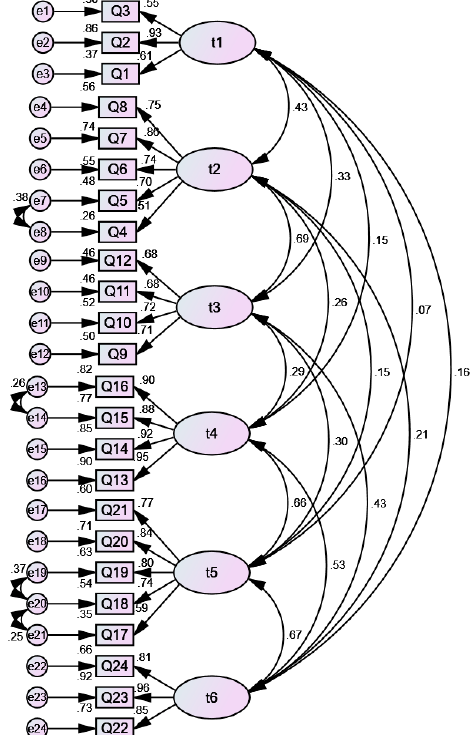
Figure 1. CFA of the QWLSKT. Model fit: χ 2 = 691.447, df = 235, p < 0.000, CFI = 0.91, TLI = 0.90, IFI = 0.91, RMSEA = 0.067 (90% CI [0.61, 0.73]), AIC = 821.447, BIC = 1086.494. CFA, confirmatory factor analysis; QWLSKT, quality of work life scale for kindergarten teachers; CFI, confirmatory factor index; TLI, Tucker-Lewis index; IFI, incremental fit index; RMSEA, root mean square error of approximation; AIC, Akaike information criteria; BIC, Bayesian information